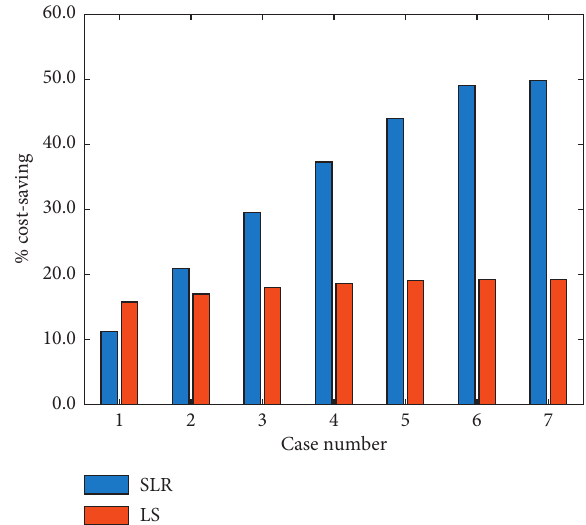
Figure 10: SLR and LS on